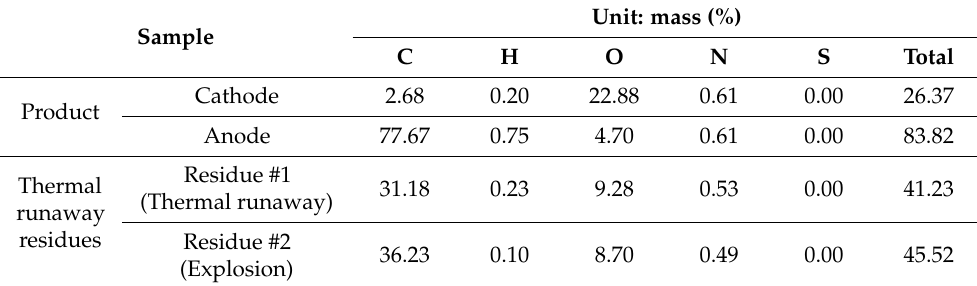
Table 3. Elemental analysis of electrodes and thermal runaway residues in lithium-ion